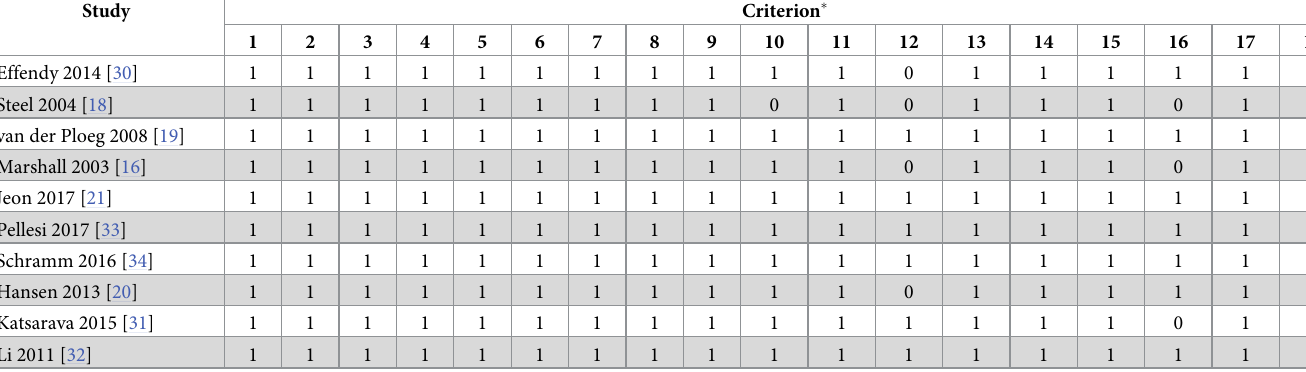
Table 1. Summary of the SQUIRE statement quality appraisal results